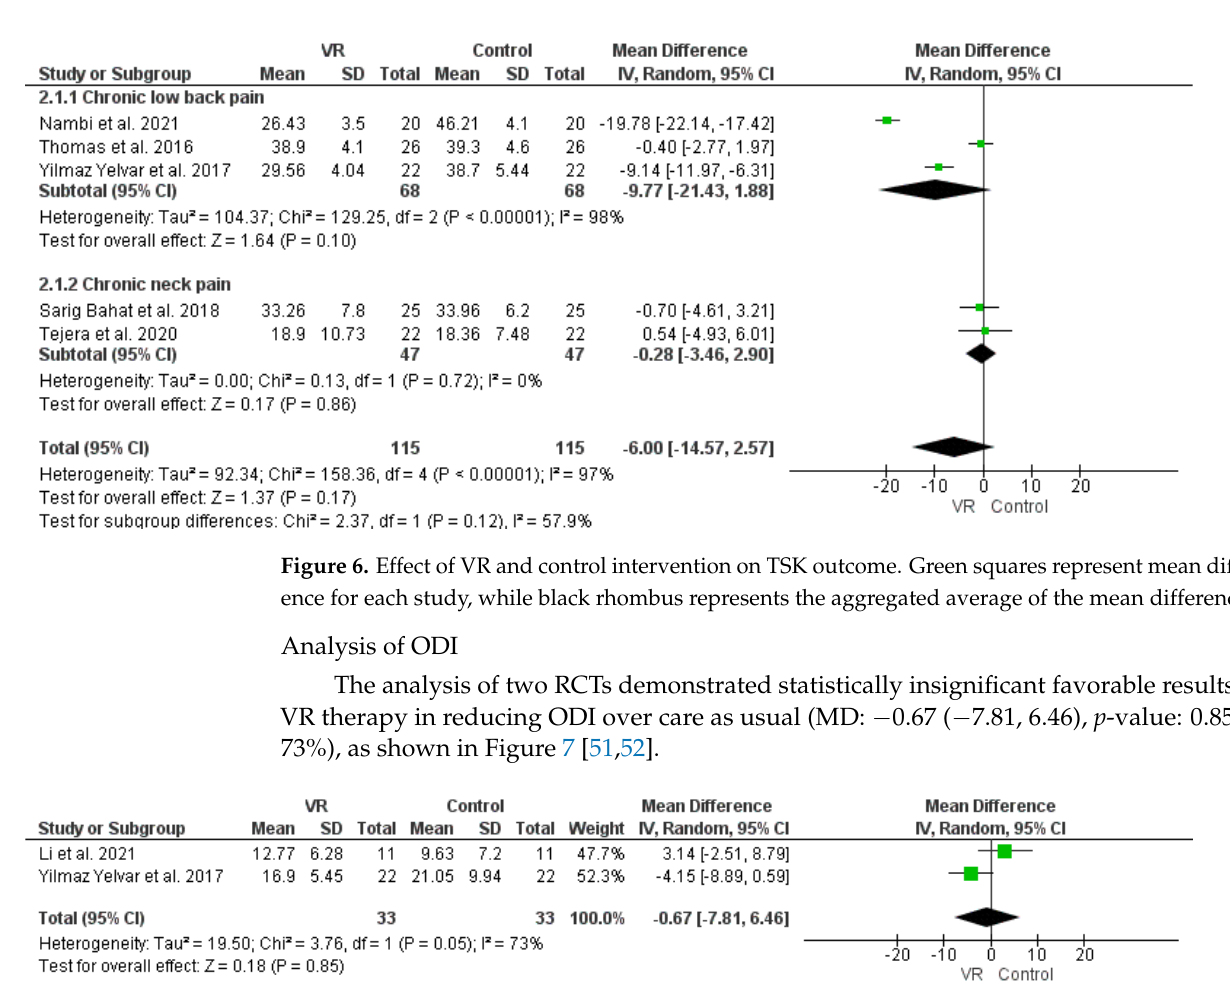
Figure 8. Effect of VR and control intervention on measure of ODI outcome. Green squares repre ‐ mean the mean differences.